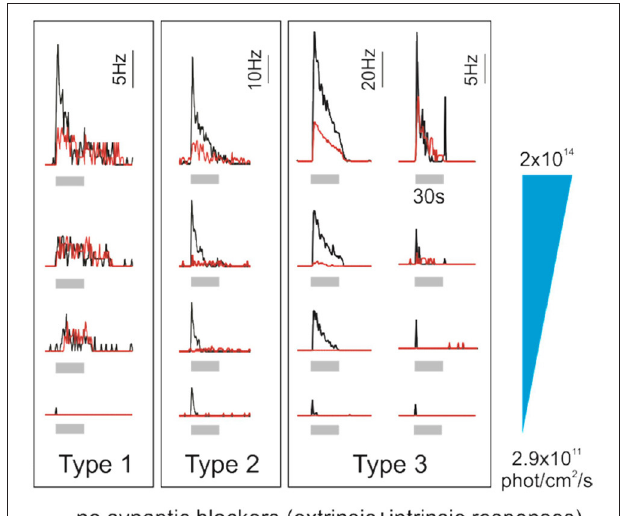
FIGURE 3 | Human ipRGCs integrate extrinsic signals. Individual examples of type 1, 2, and 3 ipRGCs’ responses to increasing irradiance light pulses (gray bars, 30s, 470nm; from bottom to top, irradiance is 2.9 × 10 11 , 3.5 × 10 12 , 2 × 10 13 , and 2 × 10 14 photons/cm 2 per second). Red traces represent the responses of pharmacologically isolated ipRGCs, which reflect their intrinsic photosensitivity. In contrast, black traces report the responses from the same cells in the absence of synaptic blockers and thus integrating input from outer retina photoreceptors. Time course, sensitivity, and intrinsic properties of the response differ between the ipRGC subtypes. The contribution from rods/cones to the overall ipRGC responses to light also seems to be subtype-specific. Interestingly, ipRGC subtypes may receive different inputs from photoreceptors. Of note, in human, morphological and functional ipRGC subtypes are not yet fully consolidated; here, ipRGC subtypes are labeled as in the original study from which this figure is adapted